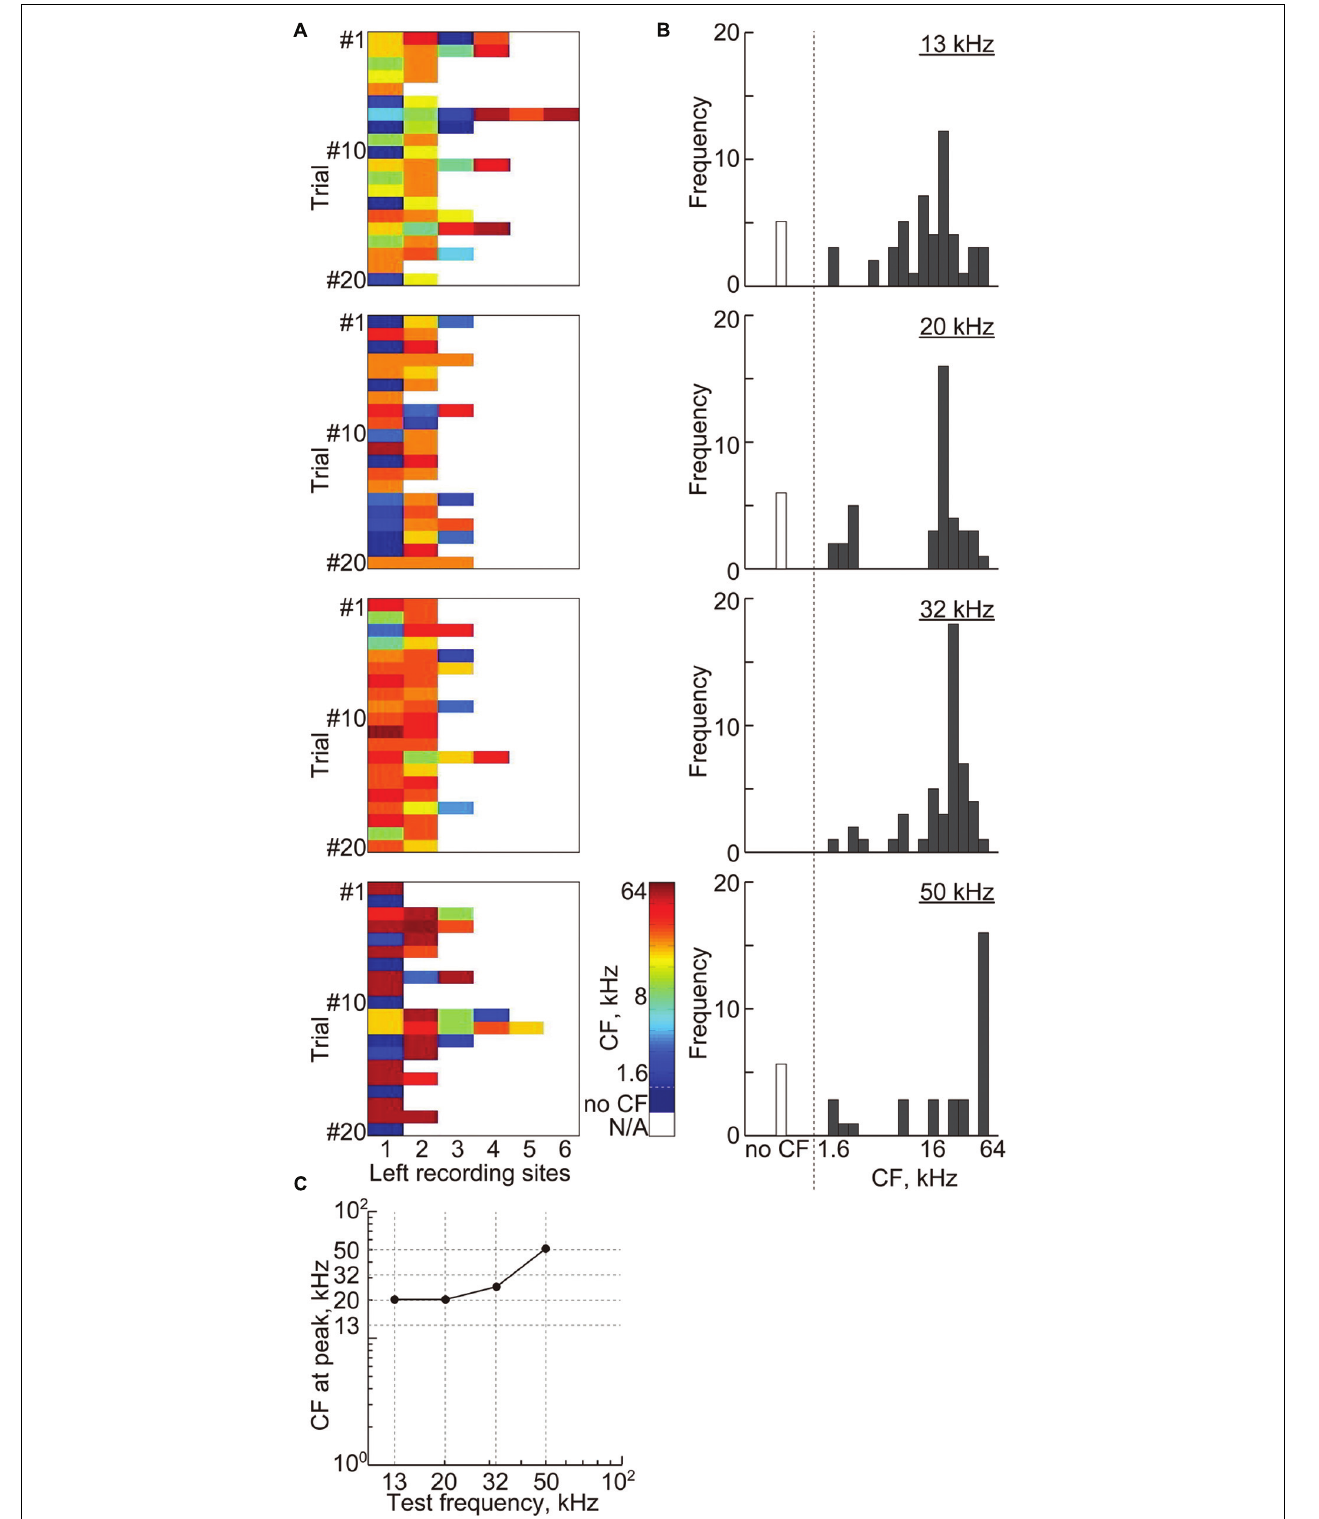
FIGURE 8 | Cortical representation of transient activities based on characteristic frequencies. (A) Each color shows the CF at the remaining recording sites with non-zero weights in the most successful 20 discrimination trials of each test frequency, i.e., 13, 20, 32, and 50 kHz. (B) The histograms of the CF shown in (A) with respect to the 18 frequencies ranging from 1.6 to 64 kHz. (C) The CFs at the peak of the histograms with respect to the test frequencies.